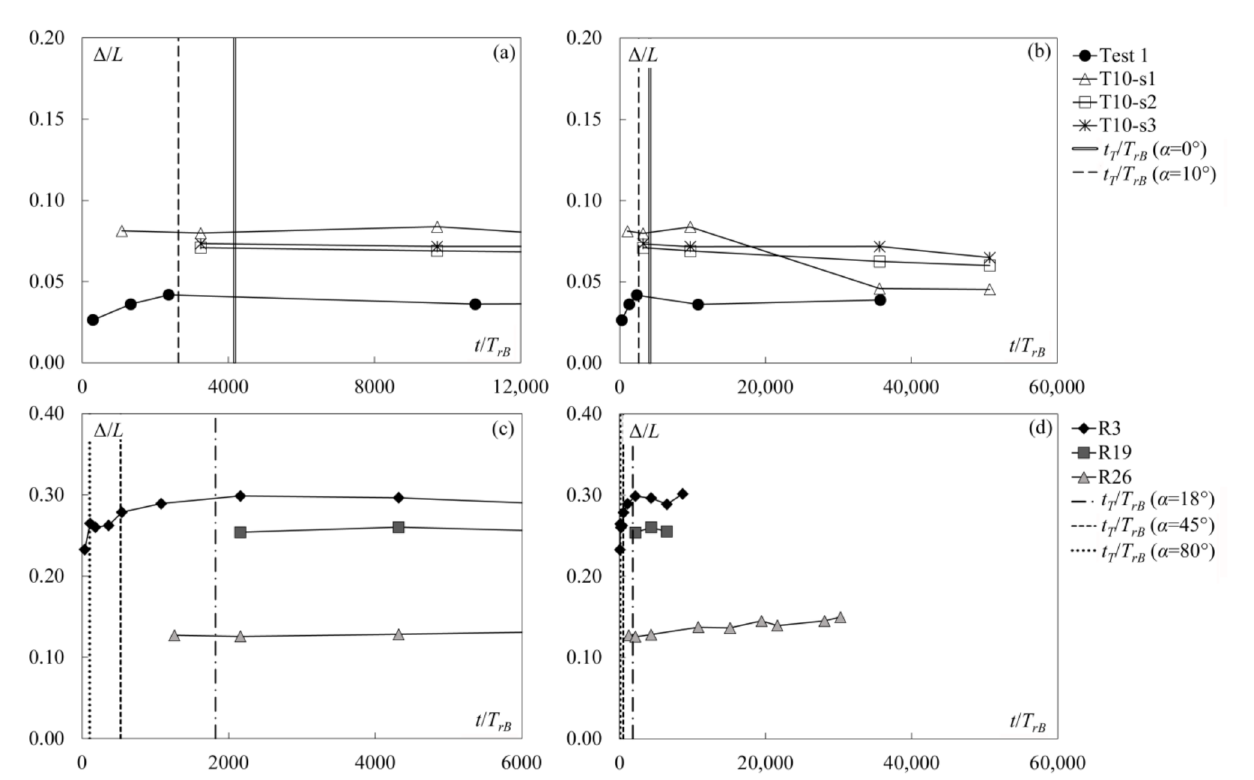
Figure 6. ∆ / L versus t / T rB for selected tests pertaining to bed sills (Test 1 of Gaudio and Marion [1] and tests T10-s1, T10-s2 and T10-s3 of Ben Meftah and Mossa [3]): for ( a ) t / T rB < 12,000 (detailed view) and ( b ) total test duration; ∆ / L versus t / T rB for selected tests pertaining to grade-control structures (tests R3, R19 and R26 of Ben Meftah and Mossa, [26]): for ( c ) t / T rB < 6000 (detailed view) and ( d ) total test